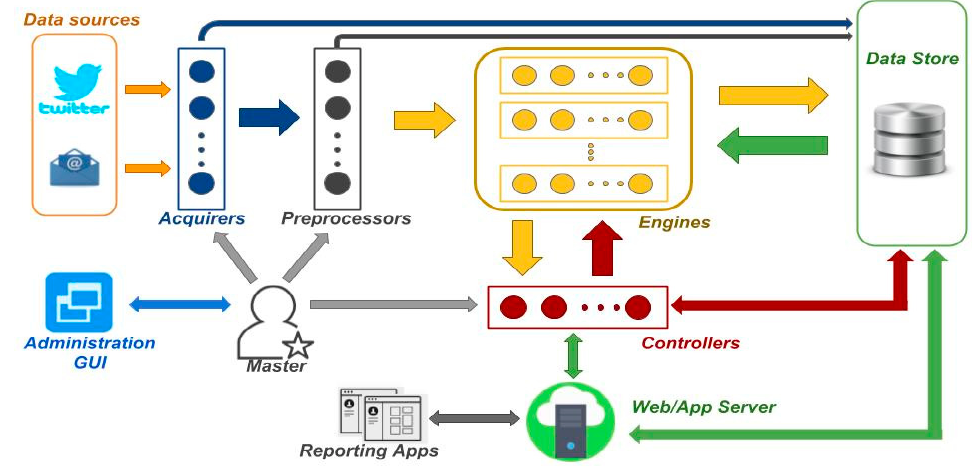
Figure 2. The ActoDatA (Actor Data Analysis) multi-agent architecture.